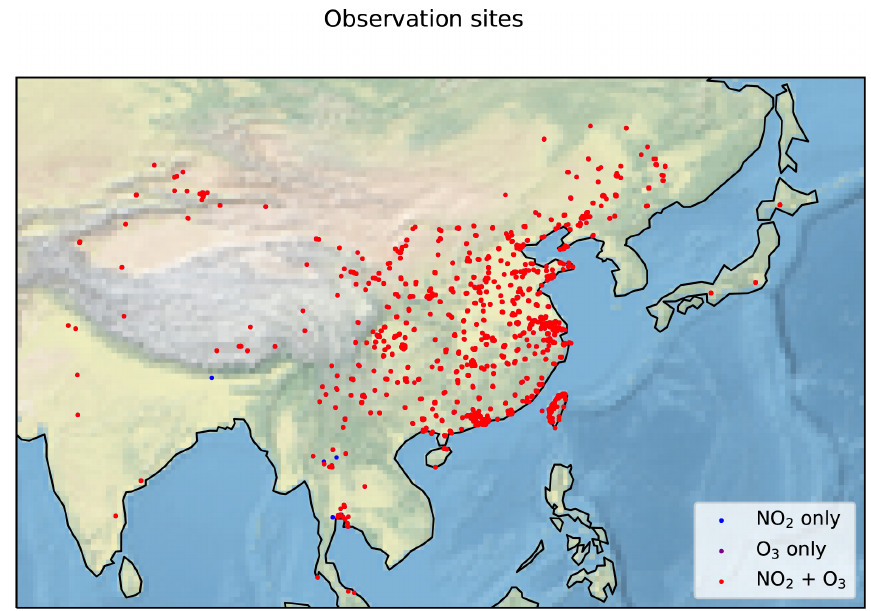
Figure A1. Close-up image of Chinese observation sites included in the analysis. Red points indicate sites with both NO 2 and O 3 observa- tions, purple points show locations with O 3 observations only, and blue points show locations with NO 2 observations only.